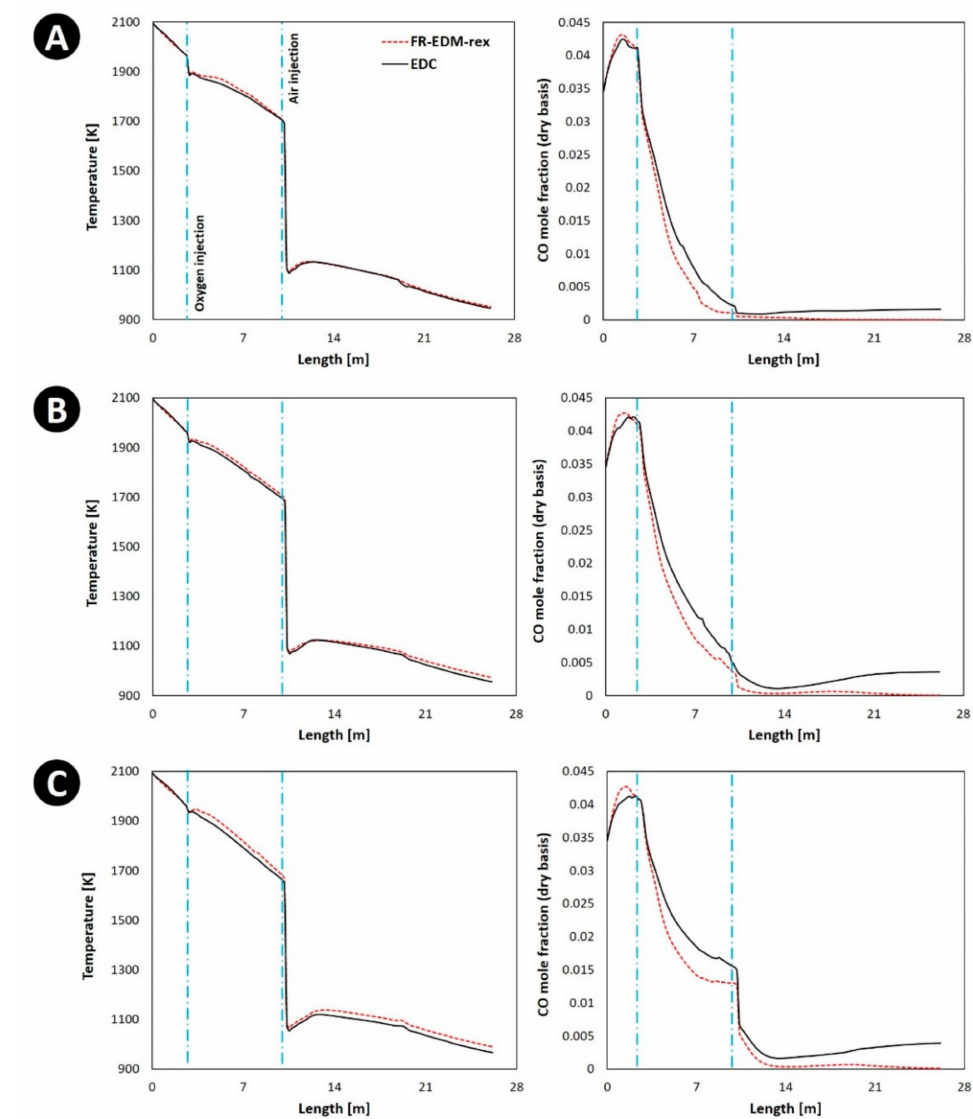
Figure 11. Comparison between FR-EDM-rex and EDC model; off-gas temperature and CO mole fraction profile for different oxygen reduction cases; ( A ) 0% reduction, ( B ) 60% redution, ( C ) 80%